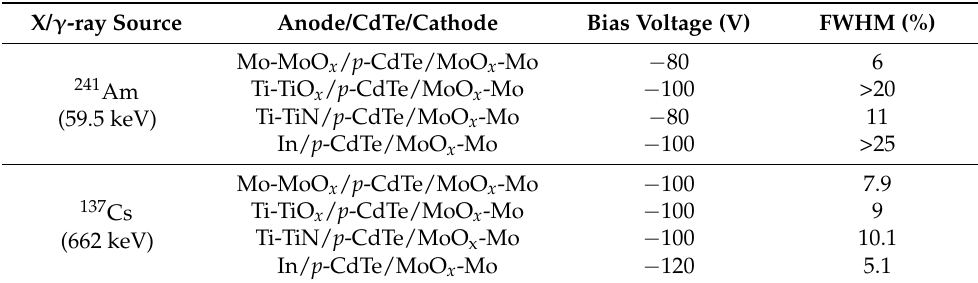
Table 1. Energy resolutions of the CdTe-based detectors with different contact materials, measured at different bias voltages for two X/ γ -ray radiation sources.